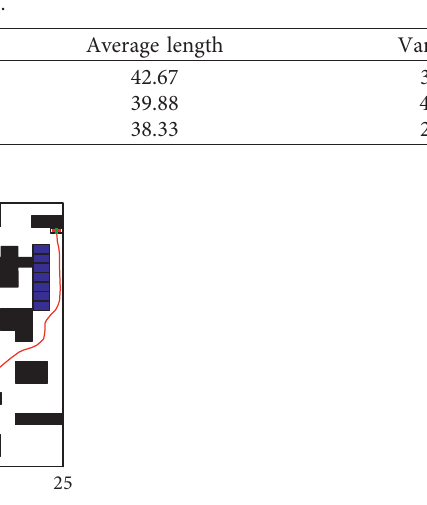
Figure 7: Path planned by the hybrid method after static obstacles added to the map.